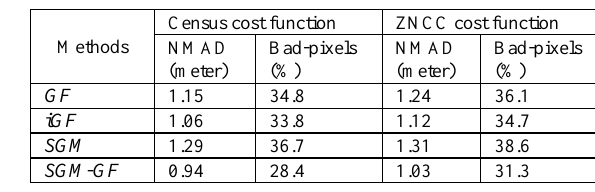
Table 1: statistical evaluation of cost aggregation methods on satellite stereo